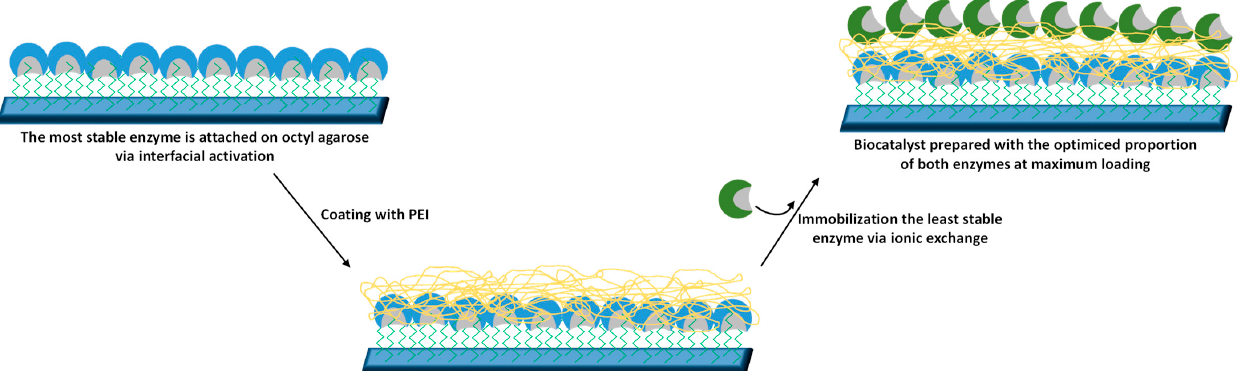
Figure 6. Preparation of a combi-biocatalyst where the most stable enzyme may be reused. First, the most stable enzyme is immobilized on the support. Then, it is coated with PEI, and finally, the least stable enzyme is immobilized on the PEI layer. The least stable enzyme may be selectively released by using high ionic strength.